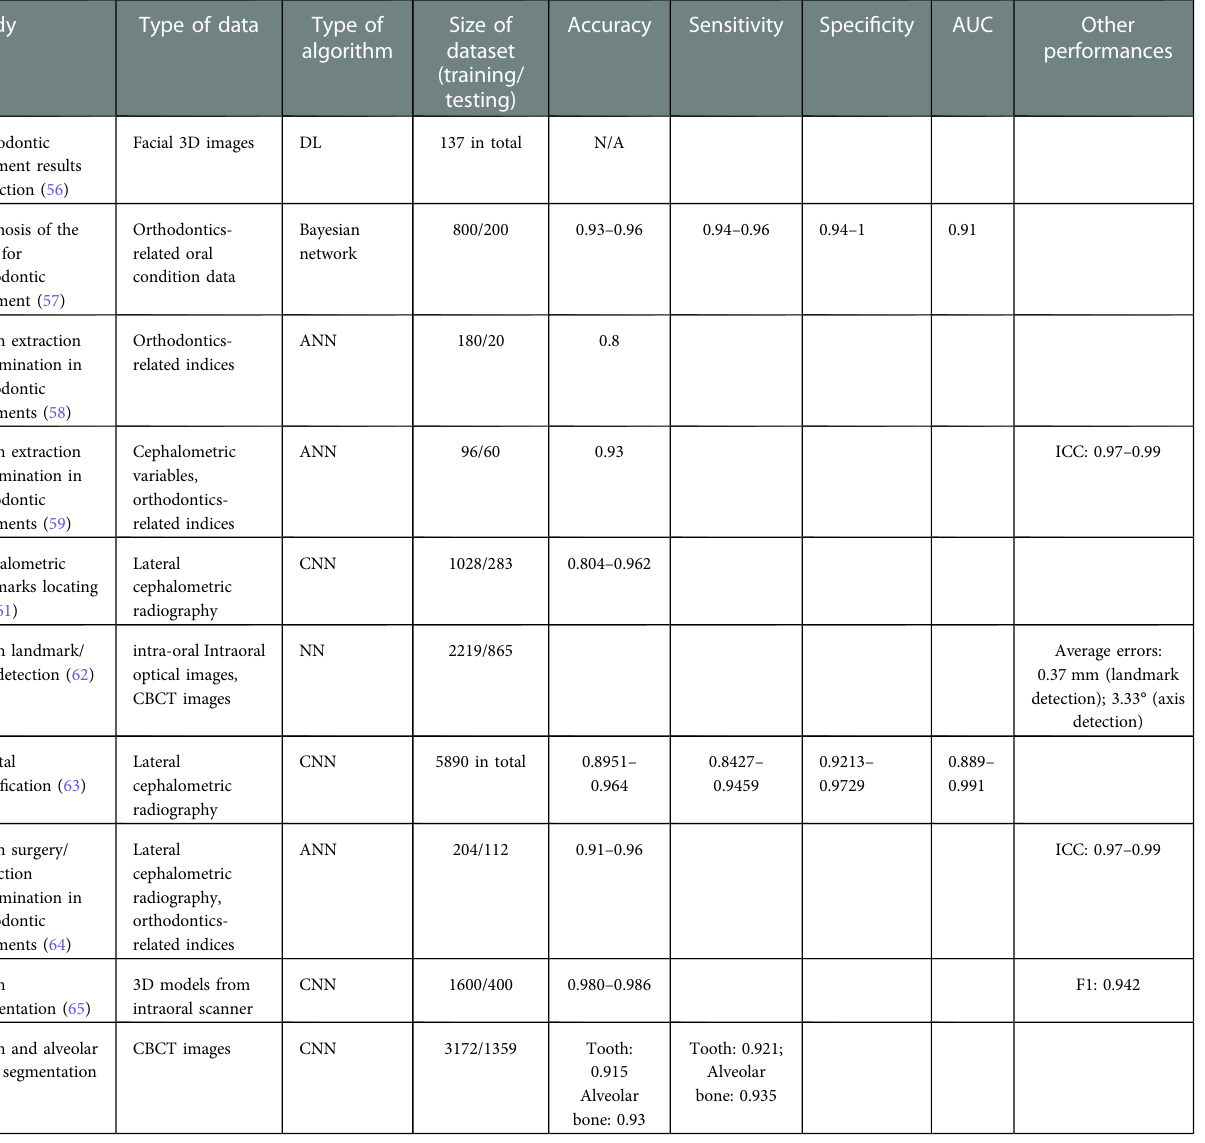
TABLE 4 Examples of AI applications in